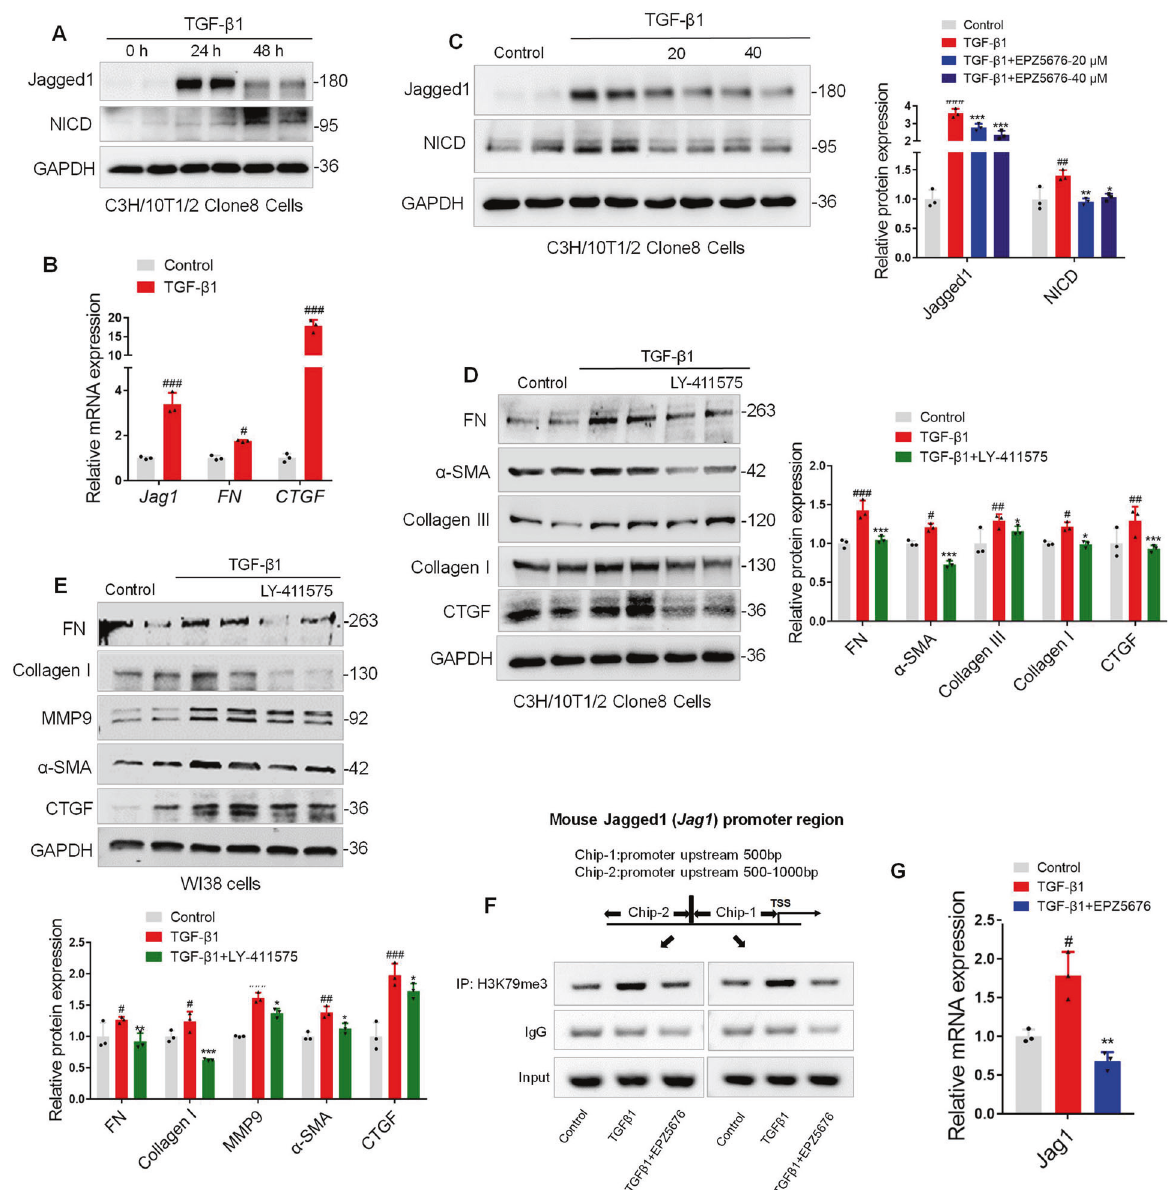
Fig. 7 The enrichments of H3K79me3 at Jag1 ’ s promoter activate the Notch signaling and accelerate the lung fi brosis. A Immunoblot analysis of Jagged1 and NICD upon the time-dependent TGF- β 1 stimulation. B mRNA levels of Jag1 and fi brosis marker genes FN and CTGF increased at 6 h after TGF- β 1 treatment; data are presented as mean ± S.D. of three independent experiments. # p < 0.05, ### p < 0.001 compared with the control group; C EPZ5676 decreased the Notch signaling (Jagged1-NICD) expression. C3H/10T1/2 Clone8 cells were pretreated with EPZ5676 (20, 40 μ M), subsequently treated with TGF- β 1, and the expression of Jagged1 and NICD were detected by western blot. D , E LY411575 downregulated the TGF- β 1-induced fi brosis markers both in C3H/10T1/2 Clone8 and in WI38 cells. C3H/10T1/2 Clone8 cells or WI38 cells were pretreated with LY411575 (50 μ M), subsequently treated with TGF- β 1, and fi brosis markers (FN, Collagen I/III, CTGF, MMP9, and α -SMA) were detected by western blot. F ChIP-PCR for enrichments of H3K79me3 at Jag1 ’ s promoter in C3H/10T1/2 Clone8 cells. C3H/10T1/2 Clone8 cells were pretreated with EPZ5676 and then incubated with TGF- β 1 for 6 h. G EPZ5676 inhibited Jag1 mRNA level in TGF- β 1-induced fi brosis. All data are presented as mean ± S.D. of three independent experiments. # p < 0.05, ## p < 0.01, ### p < 0.001 compared with control; * p < 0.05, ** p < 0.01, *** p < 0.001 compared with TGF- β the severity of pulmonary fi brosis. Importantly, studies on The fi ndings described above provide evidence that DOT1L may constitutive DOT1L knockout mice uncover that DOT1L is essential serve as a novel target during the pulmonary fi brogenesis. for embryonic development and prenatal hematopoiesis [36]. Given the premature death of homozygous DOT1L knockout mice, Dot1l + / − were newly constructed in the present study. Dot1l + / − mice showed normal growth under physiological conditions but showed less sensitive to the progression of pulmonary fi brosis.